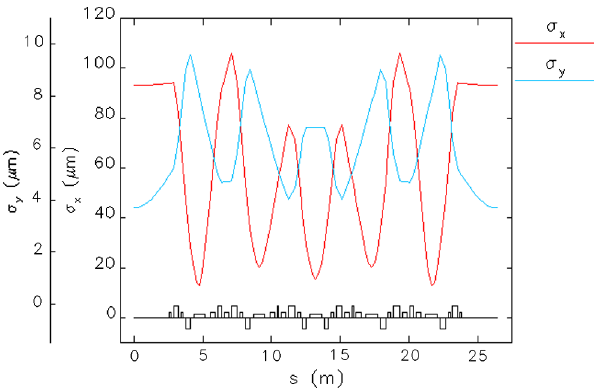
FIG. 3. The beam size in a super period of the storage ring.